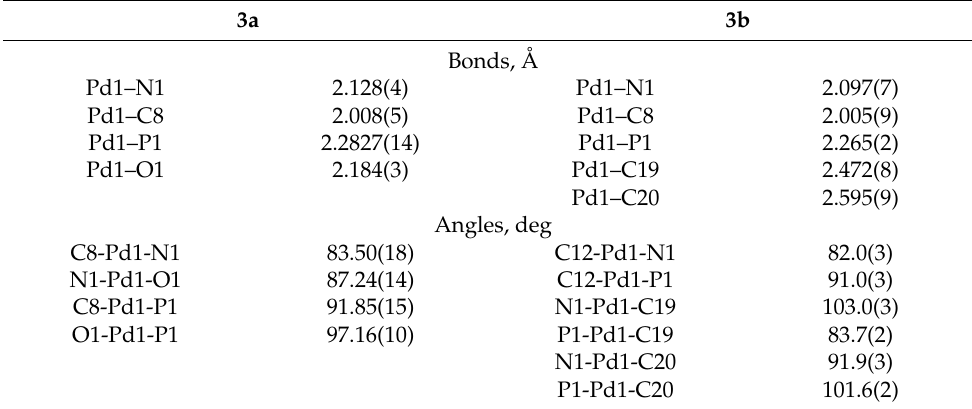
Figure 4. Molecular structure of 3b . Noncoordinated mesylate anion is now shown. Thermal ellipsoids are shown at 0.15 probability level. H atoms are omitted for clarity. Isopropyl substituents in Xphos are shown in wireframe style for clarity. Table 2. Selected bond length and angles in 3a and 3b